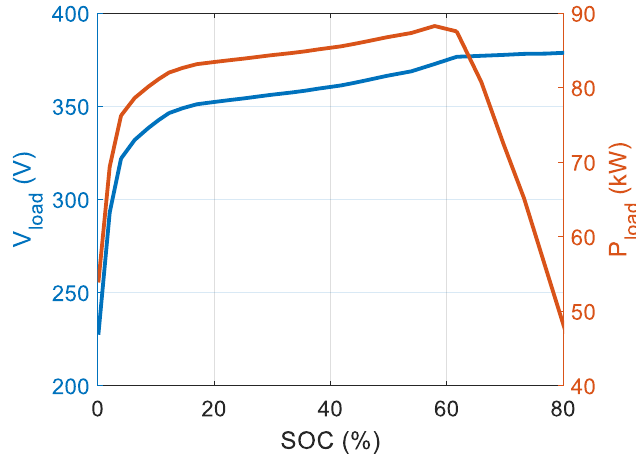
Figure 5. Voltage and power profile of the modeled ESS.